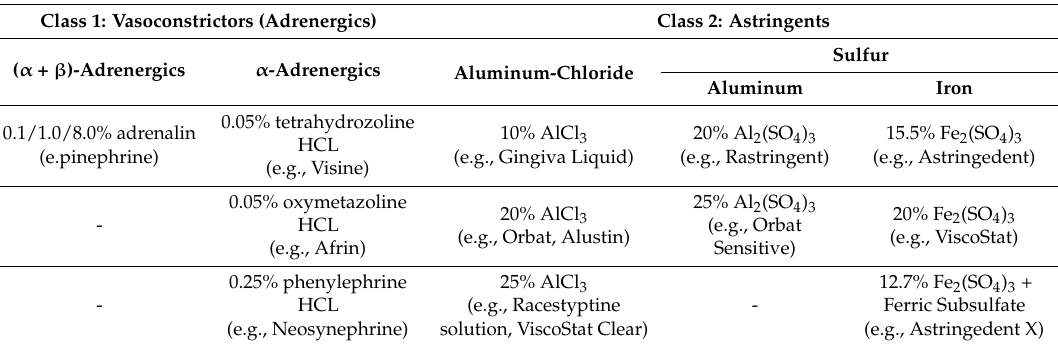
Table 2. Overview of hemostatic agents (translated acc. Nowakowska